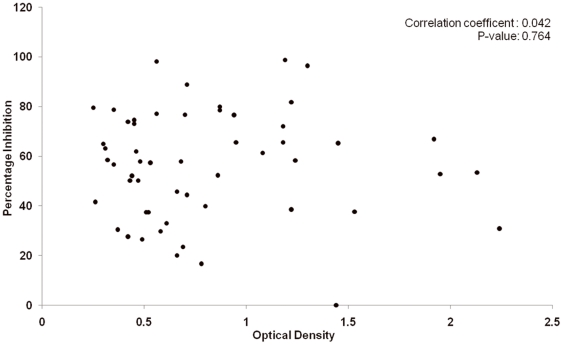
Anti-DBPII response and DBPII-Duffy positive erythrocyte inhibitory.Scatter plot showing the correlation between anti-DBPII levels and inhibition activity among Thai vivax residents (Spearman's coefficient: 0.042; P = 0.764). Fifty-four samples (1∶200 diluted plasma) were tested for their reactivity to DBPII in standard ELISA procedure and for the inhibition function of DBPII binding to Duffy positive erythrocyte measured by COS7 cell erythrocyte binding assay.